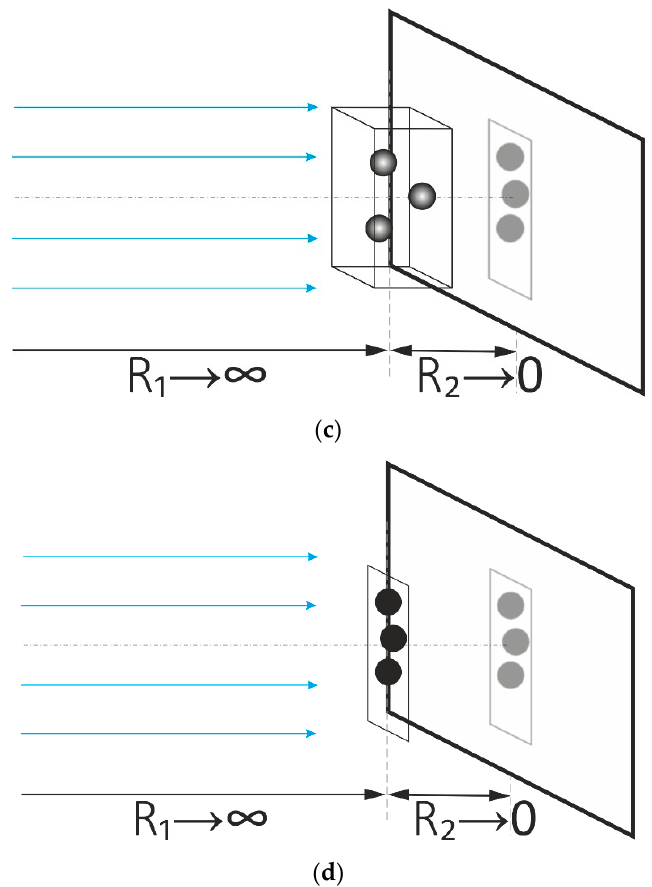
Figure 1. The formation of tomographic projections from physical to mathematical models: ( a ) standard scheme of tomography; ( b ) approximation of a plane wave beam; ( c ) approximation of the absence of diffraction in free space; ( d ) 3D object reduced to a 2D absorbing and phase shifting screen.